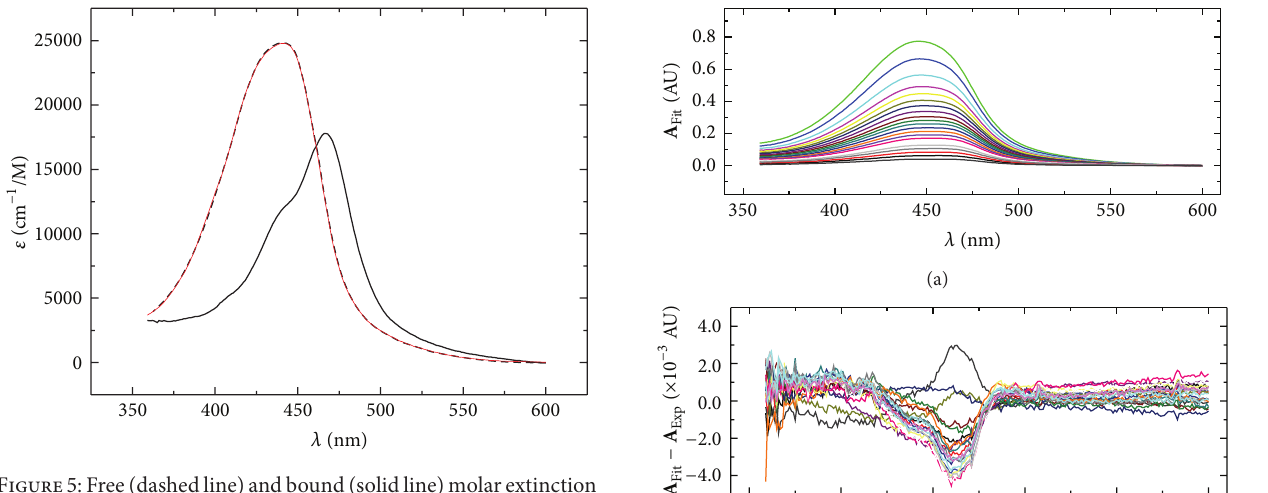
Figure 5: Free (dashed line) and bound (solid line) molar extinction coefficient spectra determined by the SVD fitting model for ActD compared with the free DNA-ActD sample extinction coefficient spectra (thin solid line).